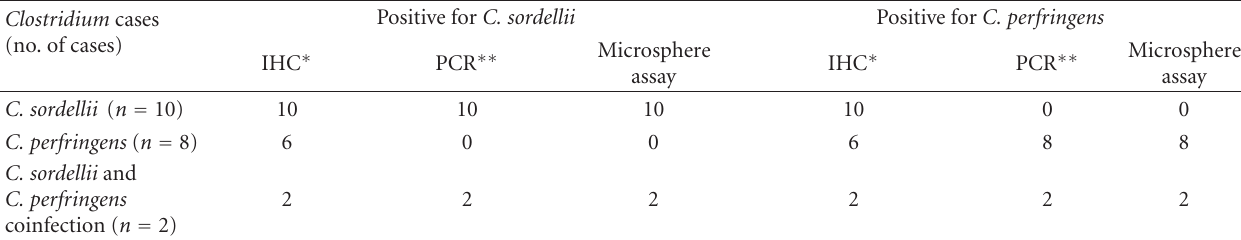
Table 4: Microsphere, PCR, and IHC assay results of CTS